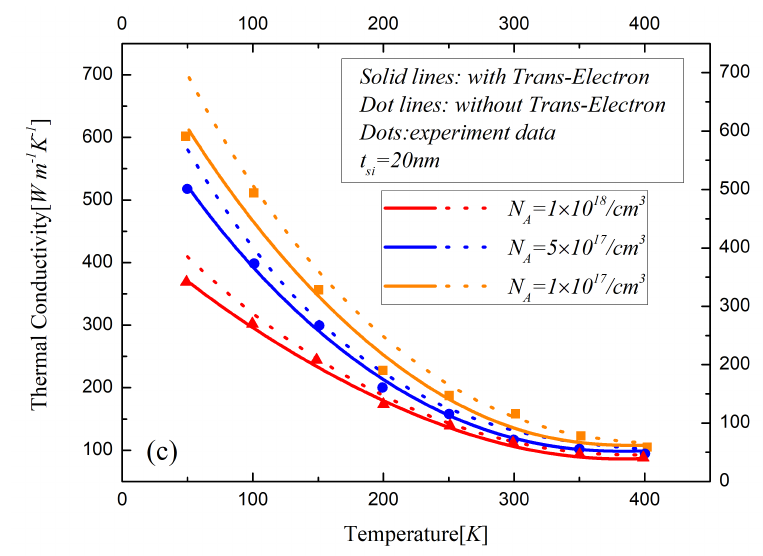
Figure 5. The influences of ( a ) boundary scattering effects, ( b ) impurity, ( c ) free and bound electron on the thermal conductivity of the 20 nm-thickness silicon film material in ultra-thin body FD-SOI